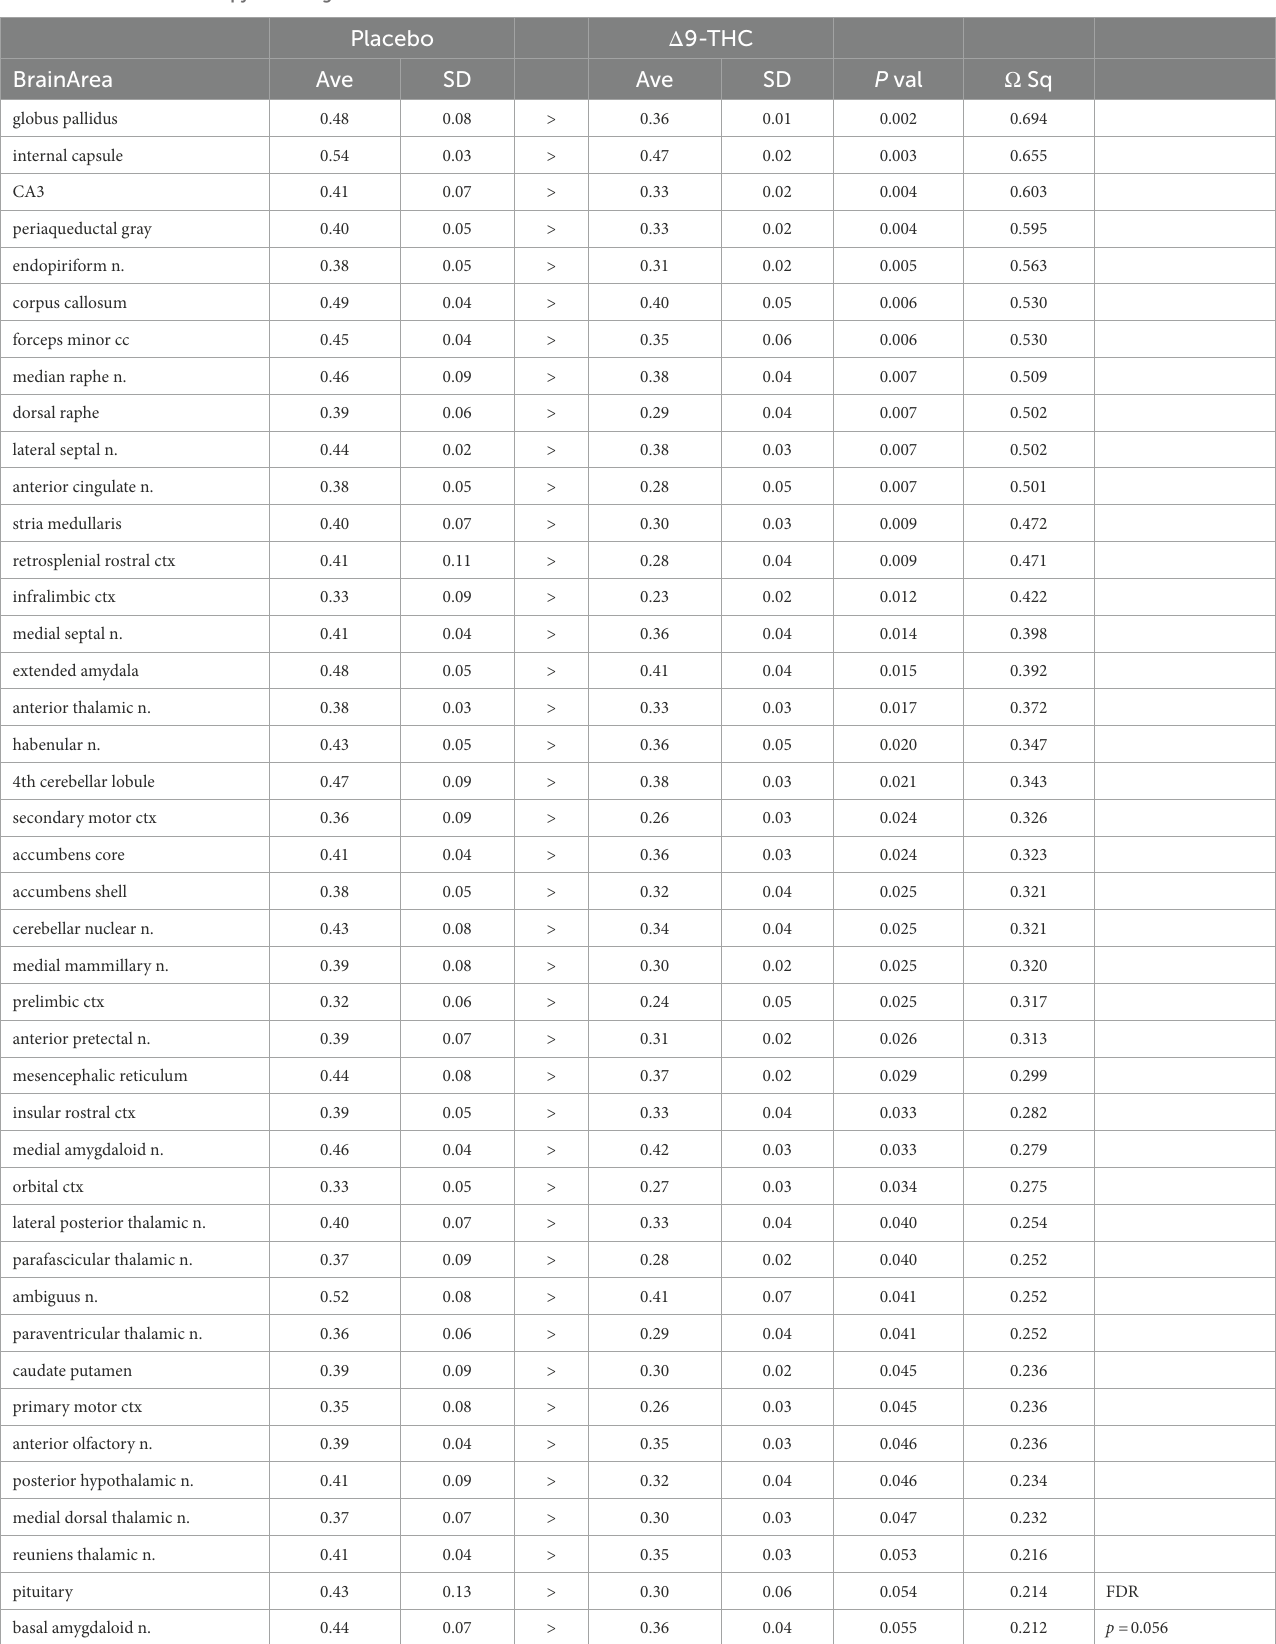
TABLE 4 Fractional anisotropy following cannabis Δ 9-THC